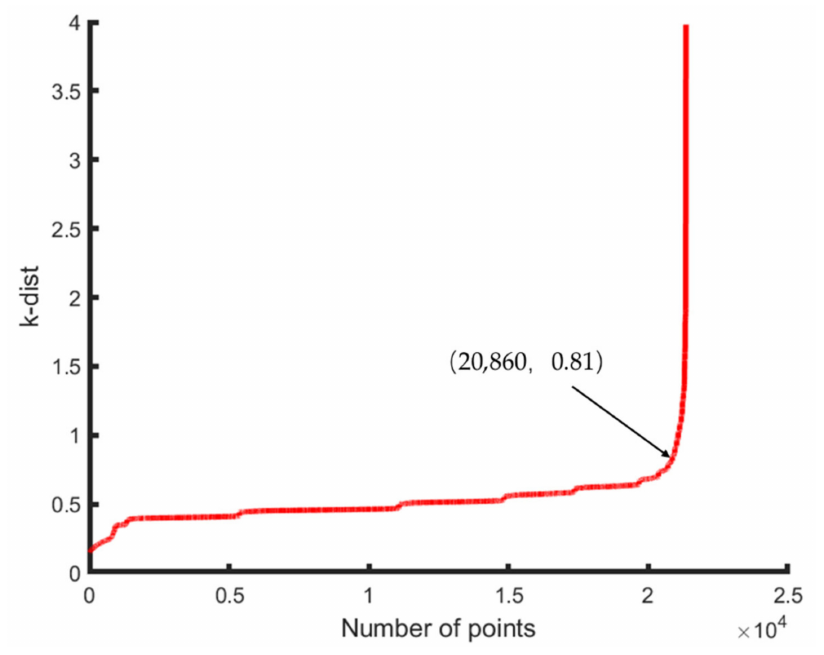
Figure 12. k-dist graph of 50 m OCS point cloud.